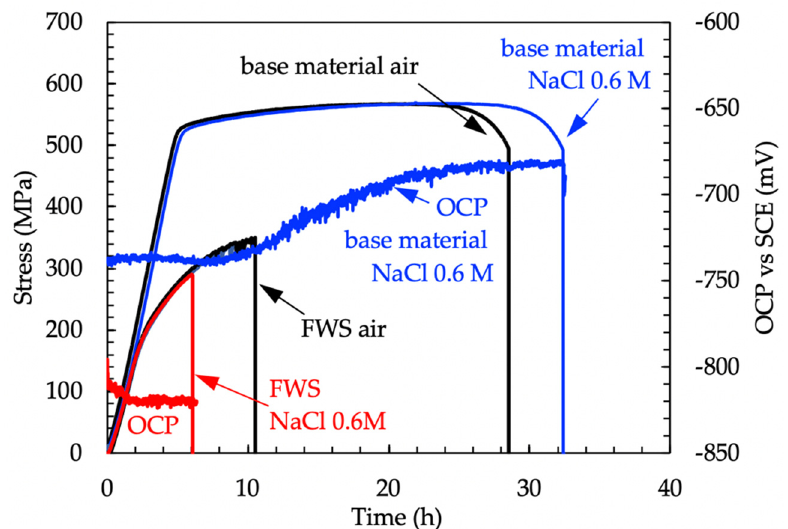
Figure 13. Stress vs time and OCP of the specimens during the slow strain ‐ rate tests.